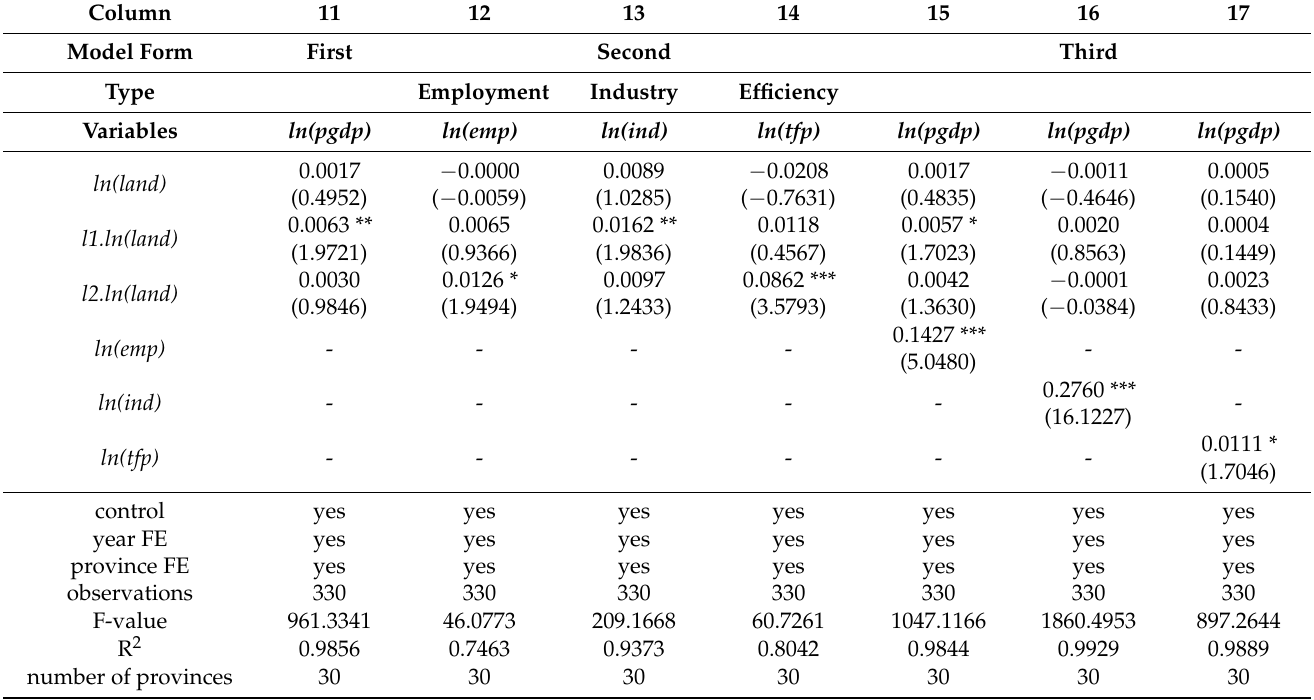
Table 4. Mediation effects of TLT on economic